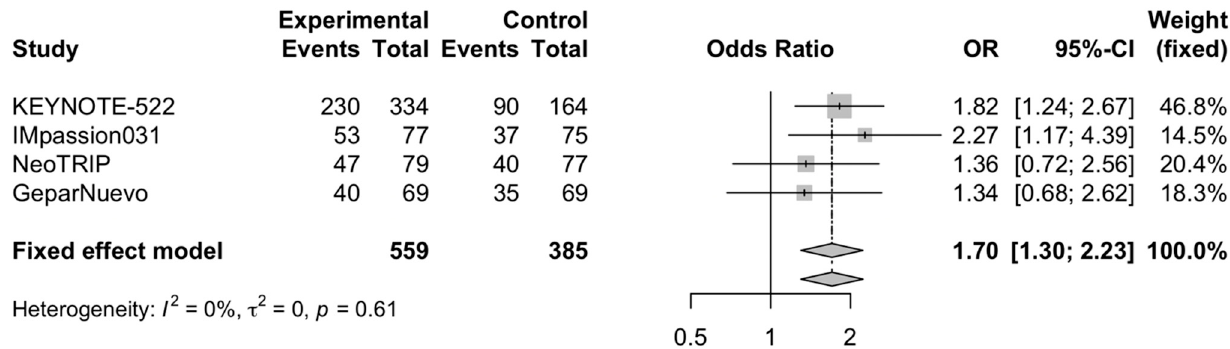
Figure 4. Forest plot of comparison between neoadjuvant chemoimmunotherapy versus